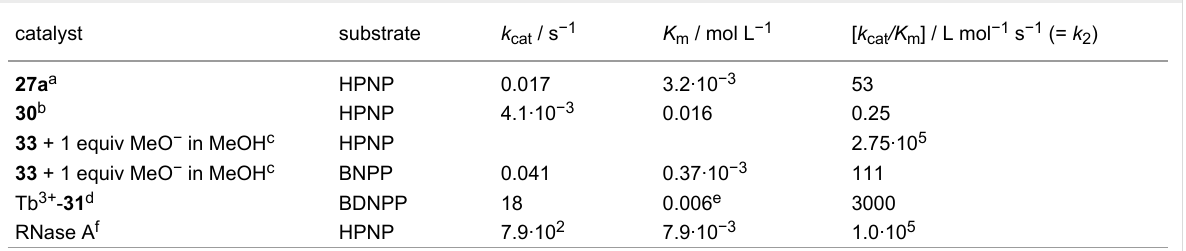
Table 4: Kinetic parameters for the catalysis of the HPNP cleavage by bimetallic complexes. Experimental details are described in the text.